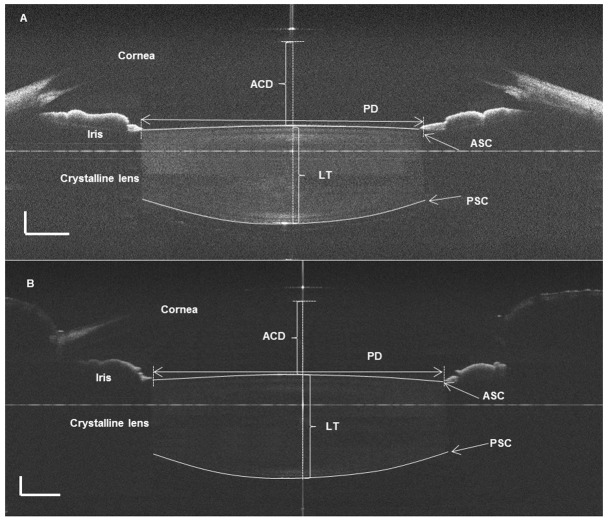
OCT images of ocular anterior segment on horizontal (A) and vertical (B) meridians.The values of dimensional parameters were obtained from the images using custom software. Anterior chamber depth (ACD) and lens thickness (LT) were measured along the perpendicular line. Pupil diameter (PD) was measured along the horizontal line from both ends of the iris. The radii of anterior and posterior surface curvatures of the crystalline lens (ASC/PSC) were measured from the two surfaces of the lens.